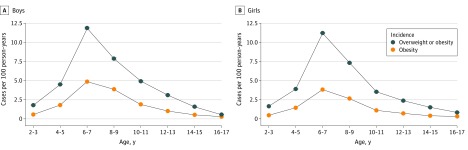
Incidence of Overweight/Obesity and Obesity by SexWhiskers represent 95% CIs.